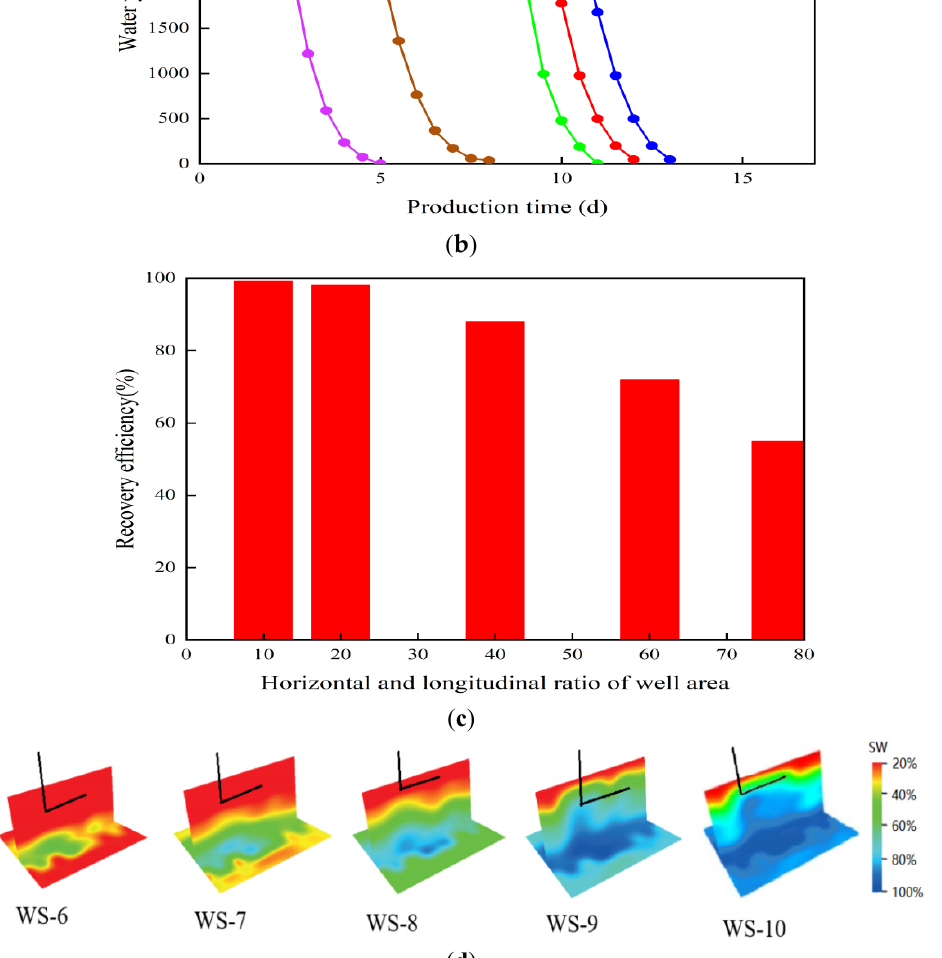
Figure 9. Experimental results of the physical simulation of water invasion in a heterogeneous bottom-water gas reservoir: ( a ) Water yield relationship curve, ( b ) gas production relationship curve, ( c ) recovery factor relationship curve and ( d ) 3D profile